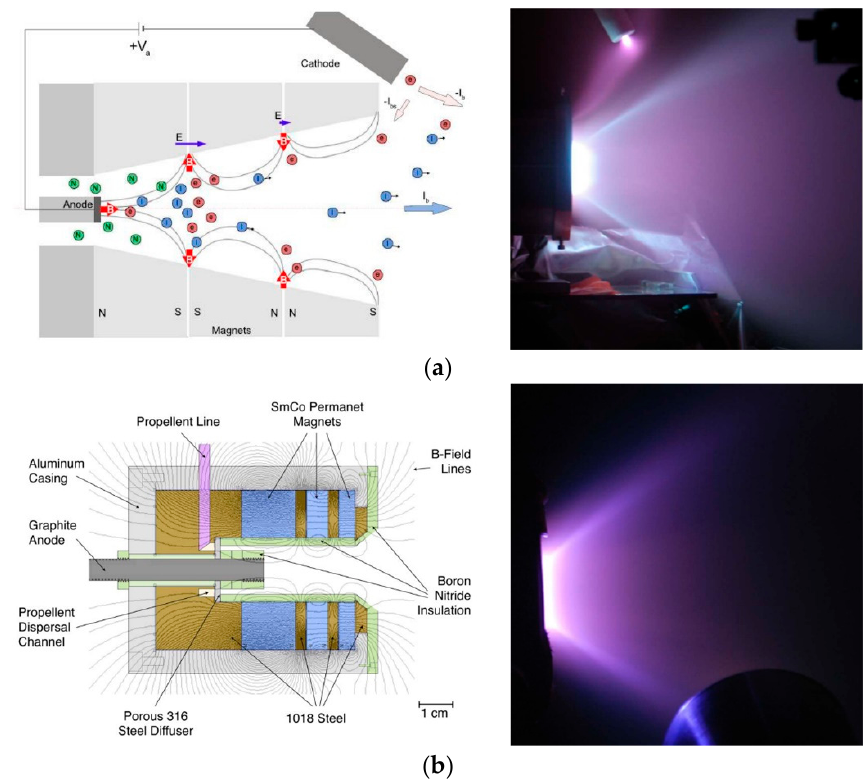
Figure 5. ( a ) DCFT of MIT and ( b ) CCFT of Stanford.